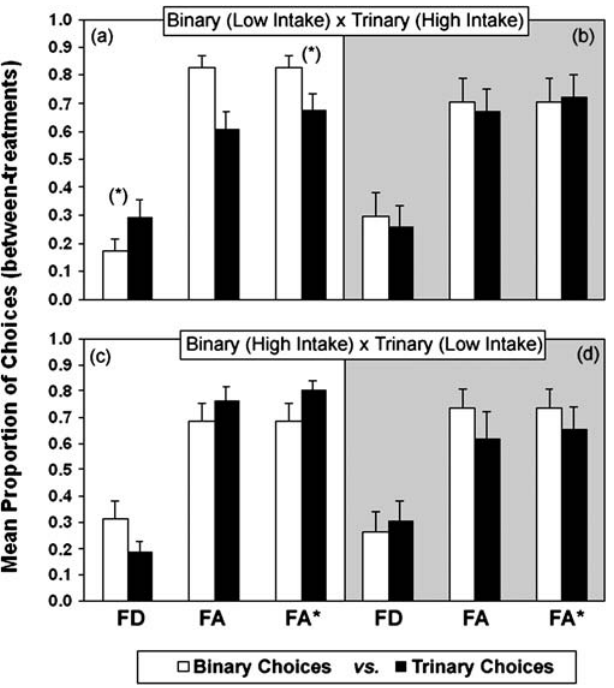
Figure 4. Between-Treatments Comparison in Binary and Trinary Choice Trials The bars show the mean ( 6 s.e.) absolute (FD and FA: leftmost and centre pairs of columns in each panel, respectively) and relative (FA*: rightmost pair of columns in each panel) proportion of choices for each option in binary (white bars) and trinary (black bars) trials when intake rate is not controlled (group NC: A and C; white background) or is controlled (group C: B and D; grey background). Relative preferences were calculated using equation 1 (see text). We compared the preference between the same two focal options between the binary context of one treatment (e.g., treatment ‘‘ High Intake ’’ ) and the trinary of the other (e.g., treatment ‘‘ Low Intake ’’ ). In group C (B and D), none of the differences between binary and trinary contexts were statistically significant. For group NC (A and C), the asterisk (*) indicates a significant violation of either regularity or the constant- ratio rule at p , 0.05. DOI: